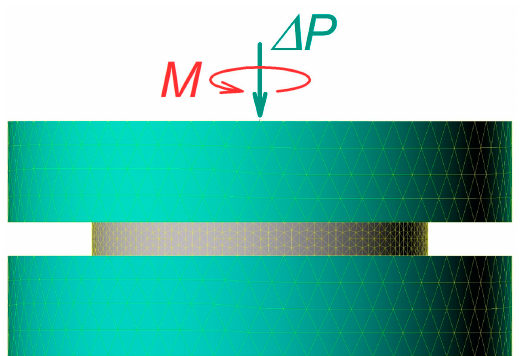
Figure 5. Geometrical model used in computations of the HPT process.